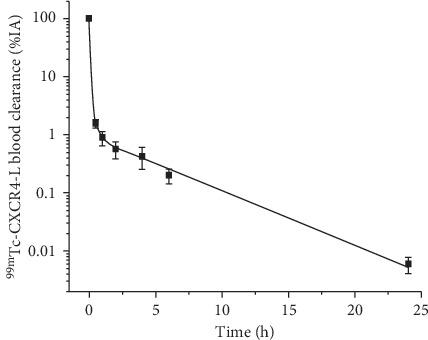

99mTc-CXCR4-L blood clearance from healthy volunteers with T1/2α = 0.81 min, T1/2β = 12.19 min, and T1/2γ = 2.03 h.